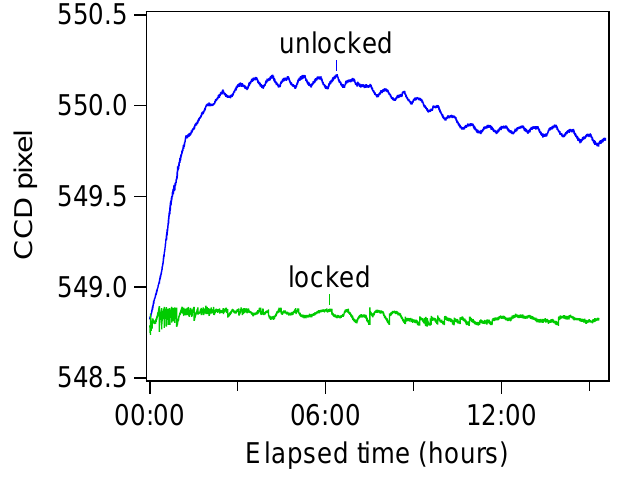
Fig. 5. Peak position in pixels on the CCD detector of the zinc peak as function of time. The upper line shows the zinc peak position in unlocked mode. The lower line shows the zinc peak position in locked mode. A drift in wavelength mapping of one pixel (corresponding to 0.0306nm) is easily reached in unlocked mode.